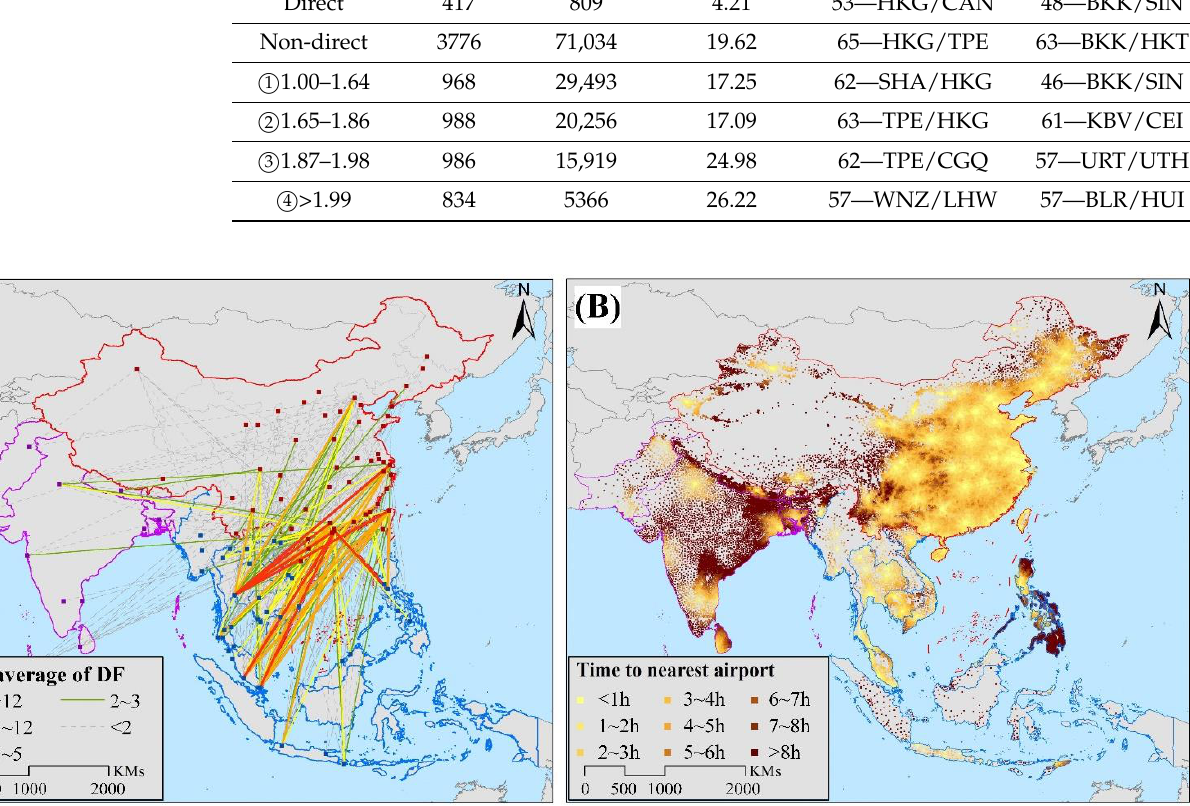
Figure 4. ( A ) The daily average number of direct flights (DF) from China airports to SA&SEA airports. ( B ) The travel time in land transport networks from each residential point to the nearest airport within each country. The figure is under the WGS-84 geographical coordinate